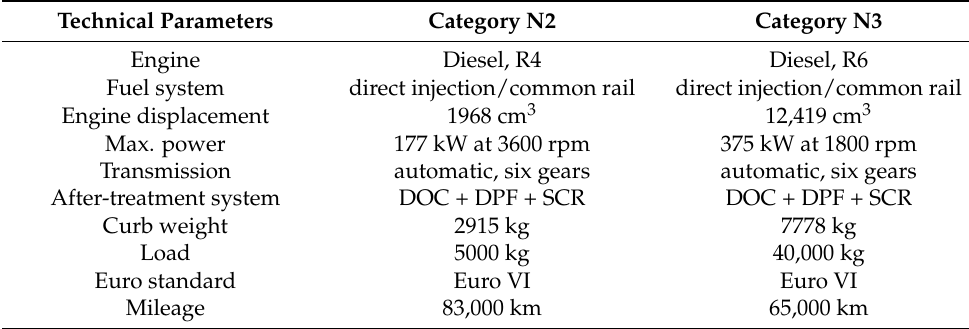
Table 2. Technical parameters of the tested heavy-duty vehicles.